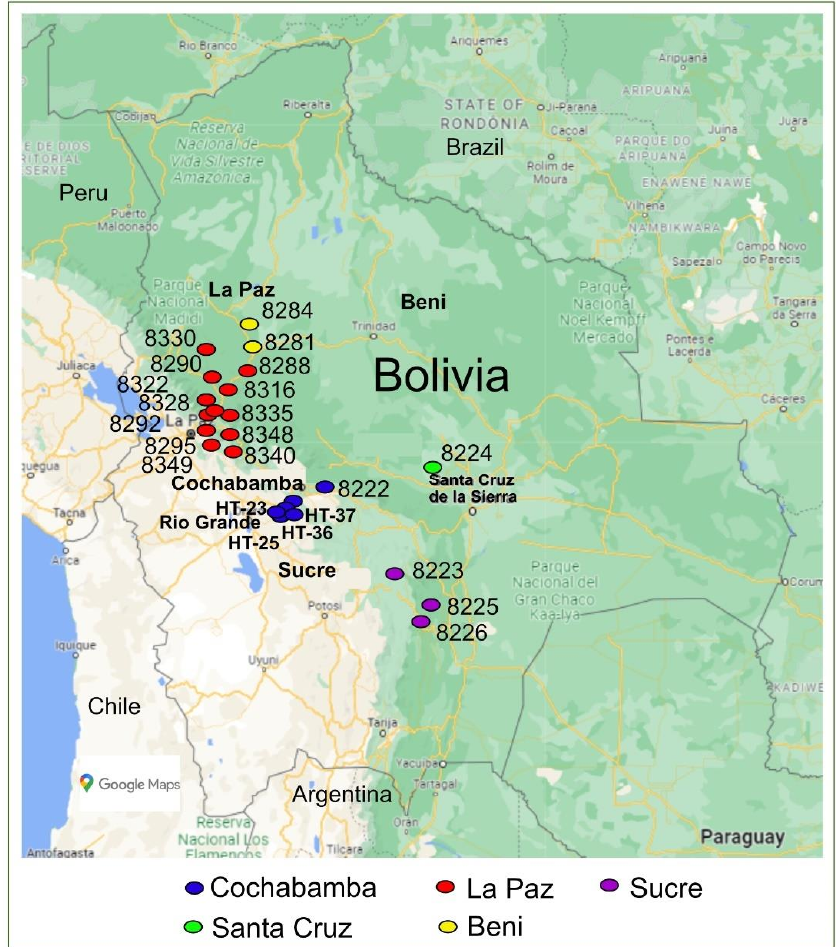
Figure 2. Geographical source of the 25 accessions collected or developed in Bolivia. Seeds of the 28 accessions were planted in 4.5-L plastic trays filled with nutrient-rich soil (0.08 L per plug) in a greenhouse at the Department of Plant Breeding, Swedish University of Agricultural Sciences (SLU). The emerging seedlings were grown under day/night temperature of ±24 °C/19 °C, 16 h of light and 60% relative humidity until sampling of leaf tissue for DNA extraction at one month after planting. Young leaf tissue was sampled separately from 10 individual plants of all accessions except one, which was represented by nine plants (279 samples in total). The fresh leaf tissue taken from each plant was placed in a separate 2-mL Eppendorf tube containing two glass beads with diameter 3 mm, and immediately dipped in liquid nitrogen. The frozen samples were stored at − 80 °C until DNA extraction.